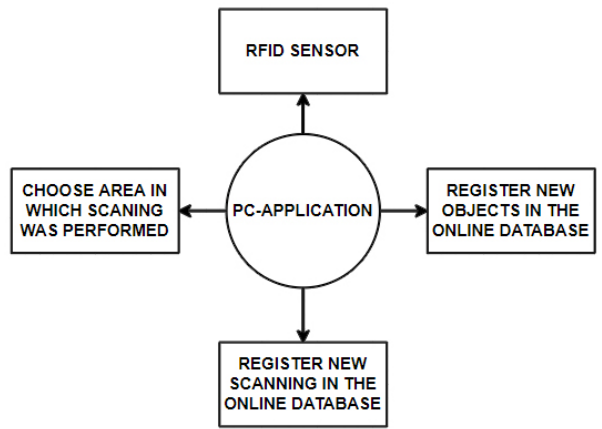
Figure 15. Structure of the developed Delphi-Application for RFID integration.